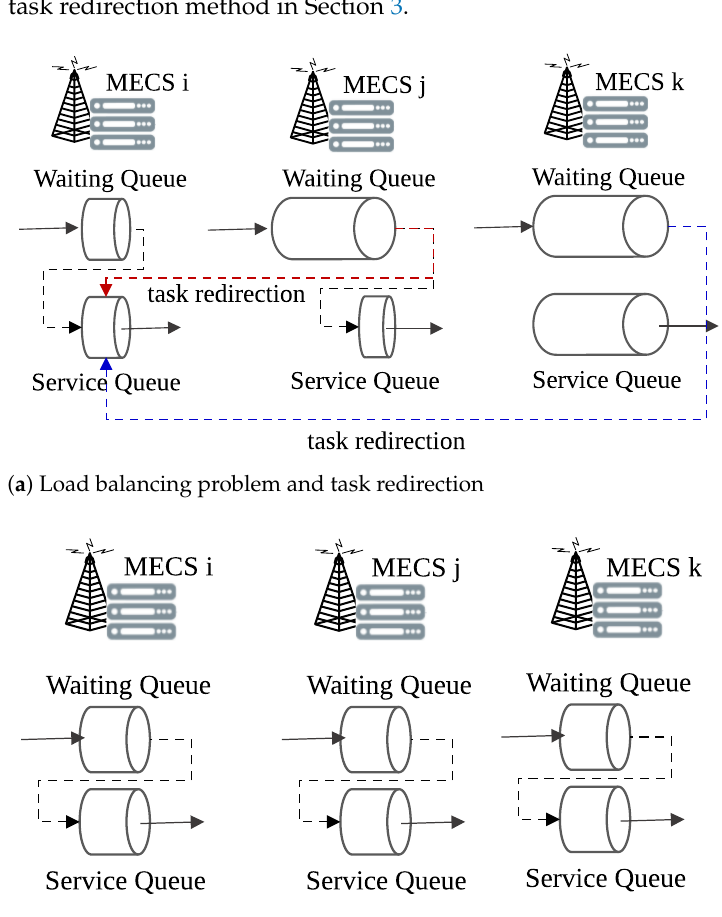
Figure 1. Load balancing problem and task redirection